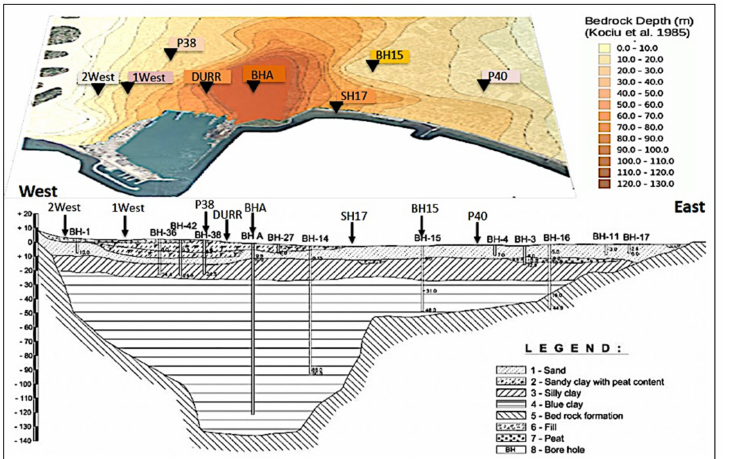
Figure 18. West − East geologic cross section developed in the framework of the Durres seismic mi- crozonation project and the sites (black arrows & triangles) where synthetic ambient noise recordings were generated. Bedrock depth iso-contours by [30]. Table 3. Information on the 8 site profiles (Figure 18) [30], used in the 1D synthetic ambient noise